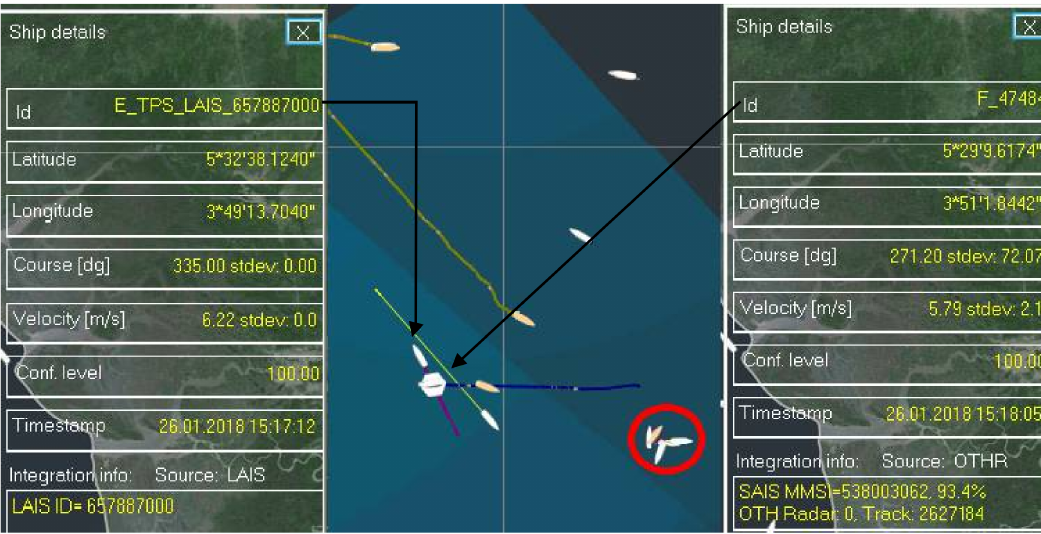
Figure 9. One MRFT and multiple AIS.